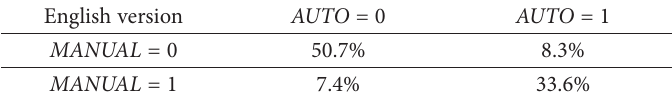
Table 8. Prediction performance of the automatic English version indicator